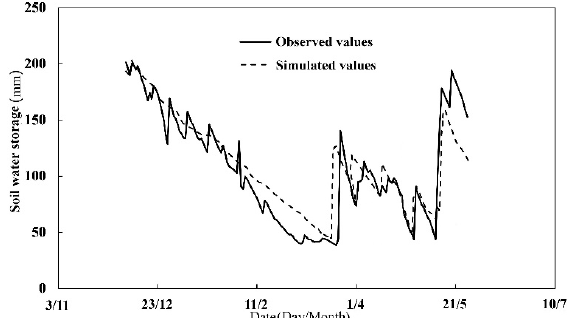
Figure 3. Comparison of measured and simulated soil water storage during the field experimenta-